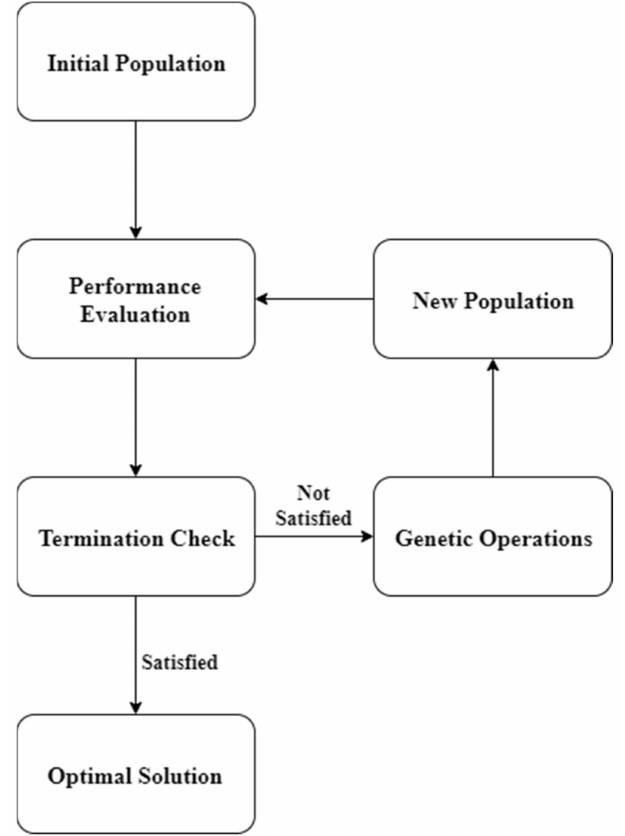
Figure 1. Working Procedure of GP